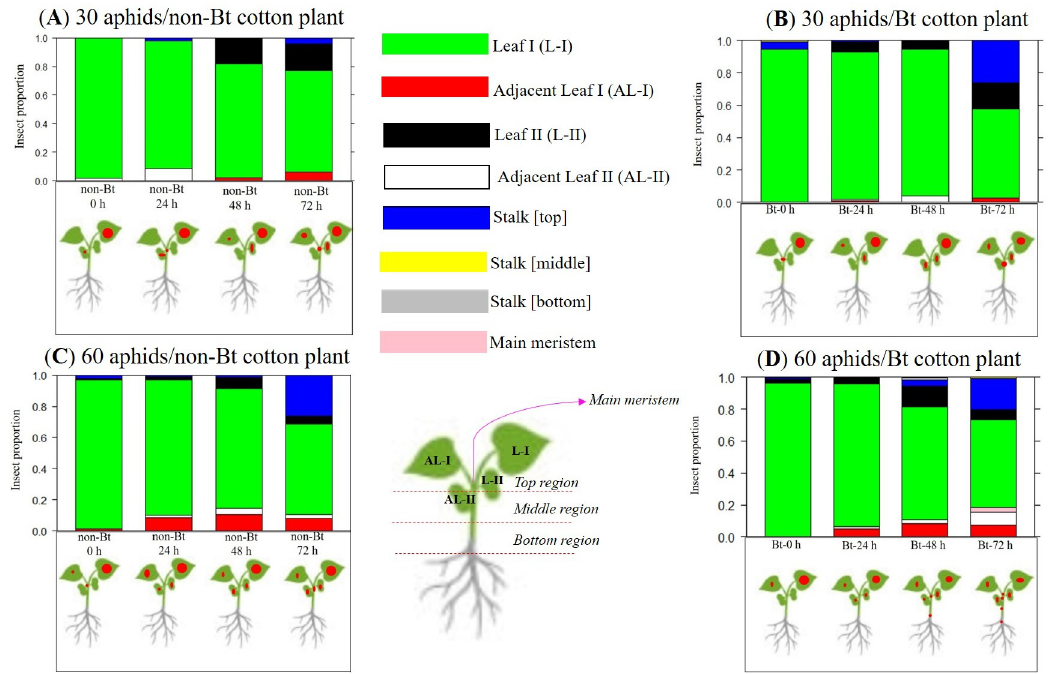
Fig 5. Multinomial distribution with occurrence rate of A . gossypii in the regions of non-Bt and Bt cotton plants at infestation times of 0 h, 24, 48 and 72 h with densities of 30 and 60 aphid/cotton plants. The red circle diameter represents the intensity of aphid infestation on cotton